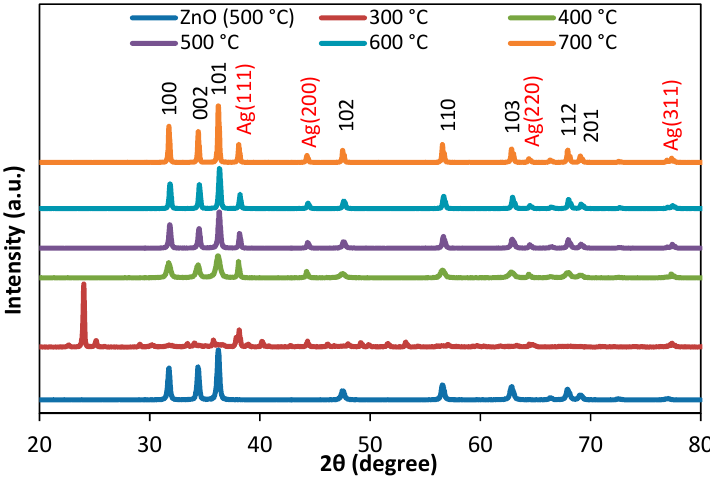
Figure 2. X-ray diffraction patterns of ZnO and Ag/ZnO synthesized at different calcination temperatures.